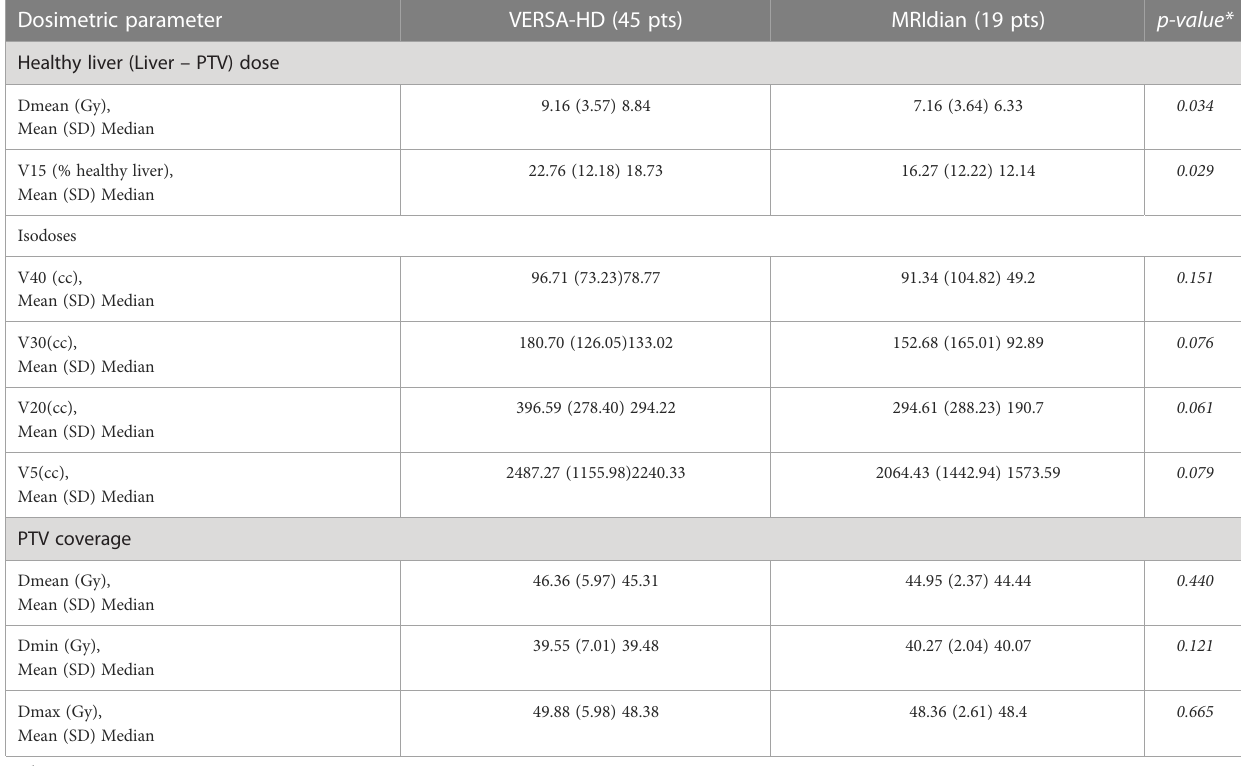
TABLE 3 Comparative dosimetry metrics for Linac- and MRIdian-based